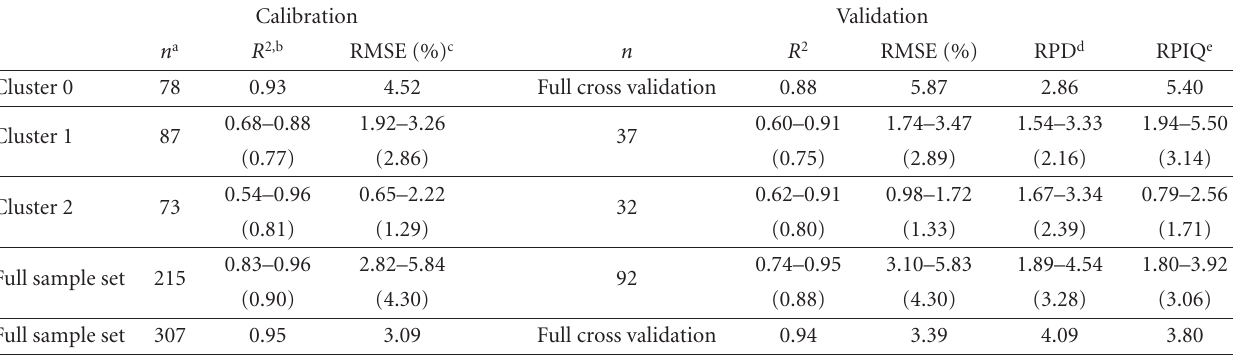
Table 6: Detailed partial least squares regression model results for soil total carbon (C t ) prediction from the subsets of visible/near-infrared di ff use reflectance spectra based on spectral classification with k -means cluster analysis. The range of values reflects the results of 10 random iterations of the models, and the number in parentheses is the mean. Detailed results are also given for full sample set models with no subsetting for comparison. For models with full cross validation (i.e., leave-one-out cross validation), the same samples used to calibrate the model were used to validate the model.